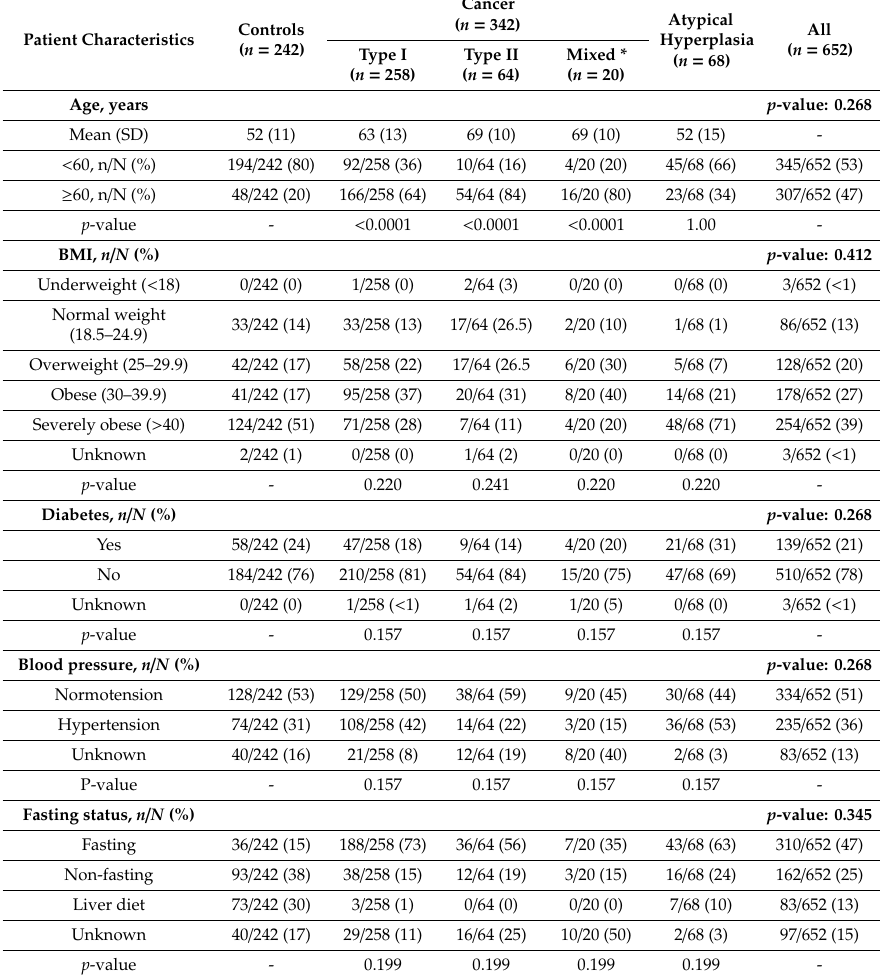
Table 1. Patient